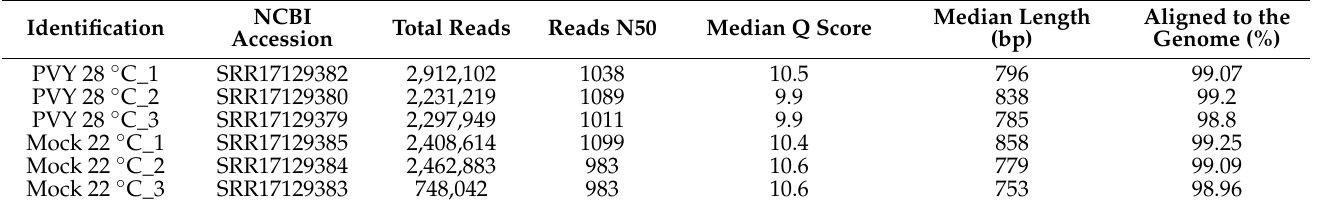
Table 2. Nanopore sequencing statistics for reads Q > 7.